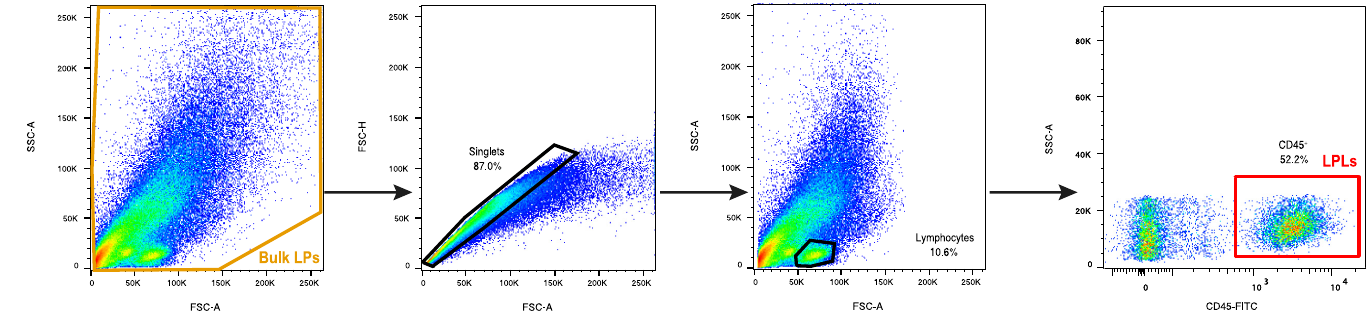
Fig 2. Representation of the gate strategy followed for LPLs isolation. Sorted CD45 + cells (LPLs) were framed in the red box.